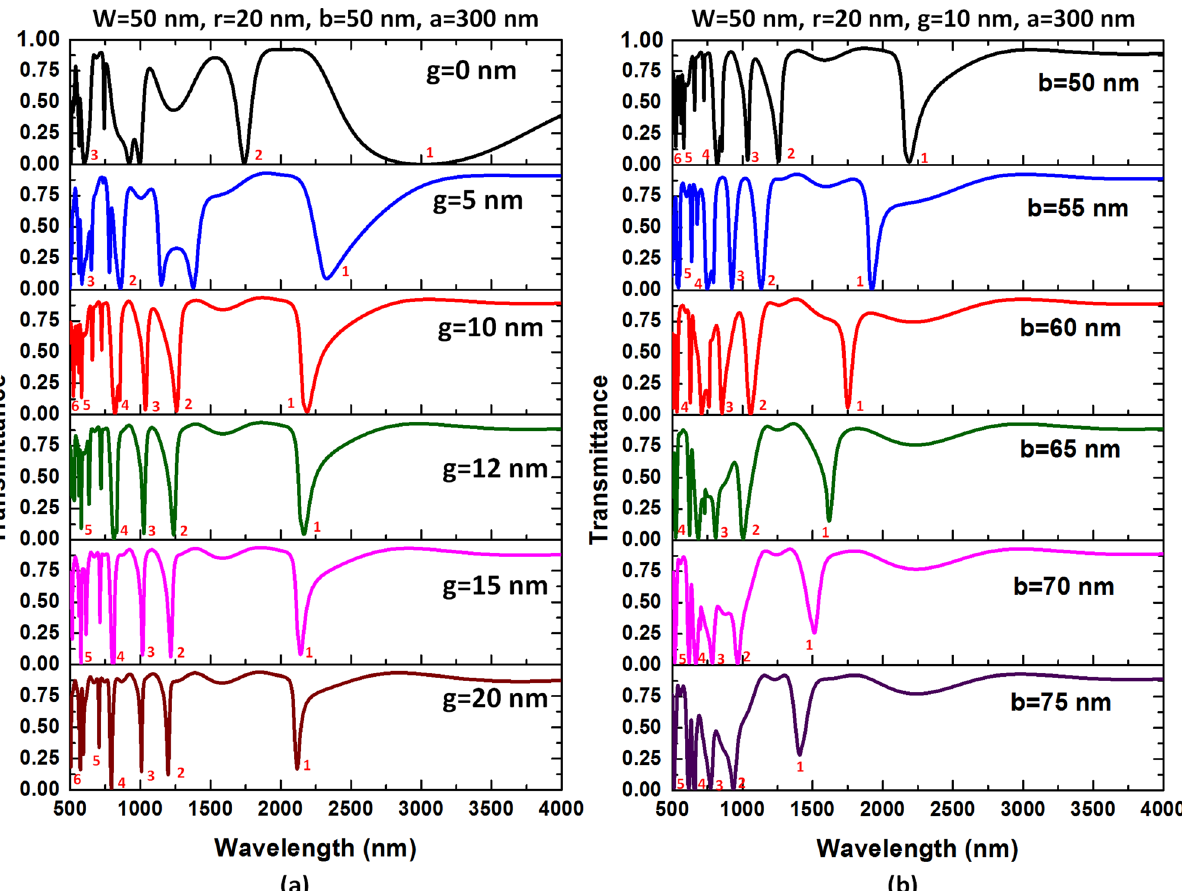
Figure 6. Transmission spectra as a function of ( a ) g variation and ( b ) b variation of the case 2 structure. The mode number marks in the figures’ inset and the structural parameters are at the top of the